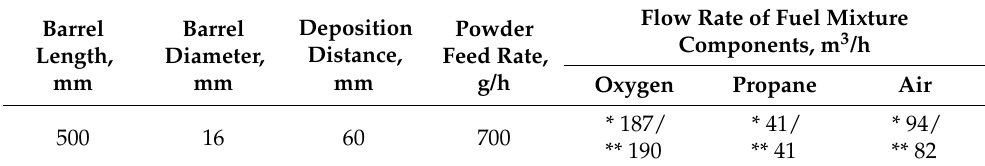
Table 1. Parameters of NiCr-70B 4 C coating deposition by a robotic complex for detonation spraying of